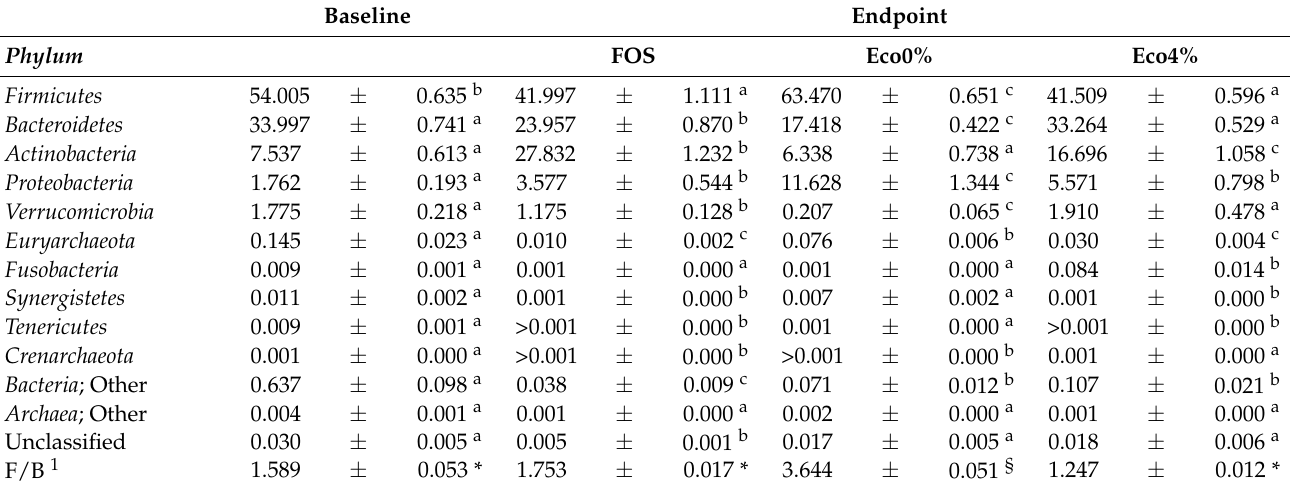
Table 1. Changes in bacterial phyla (relative abundances (%)) throughout 24 h in vitro batch culture fermentations inoculated with human feces ( n = 3 healthy donors) and administrated with fructo-oligosaccharides (FOS), Eco4%, and Eco0% as the